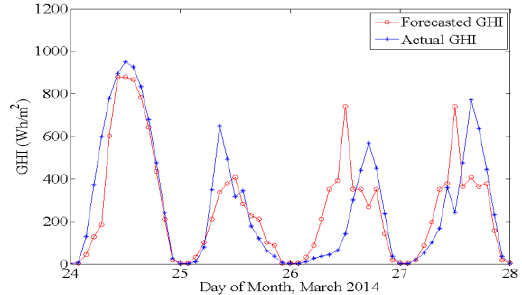
Figure 9. Comparison between two-days-ahead forecasted and actual GHI for 1 clear and 3 partly cloudy days (type 4). Table 2. Summary of Two-Day-Ahead Forecasted Errors for 4 days.